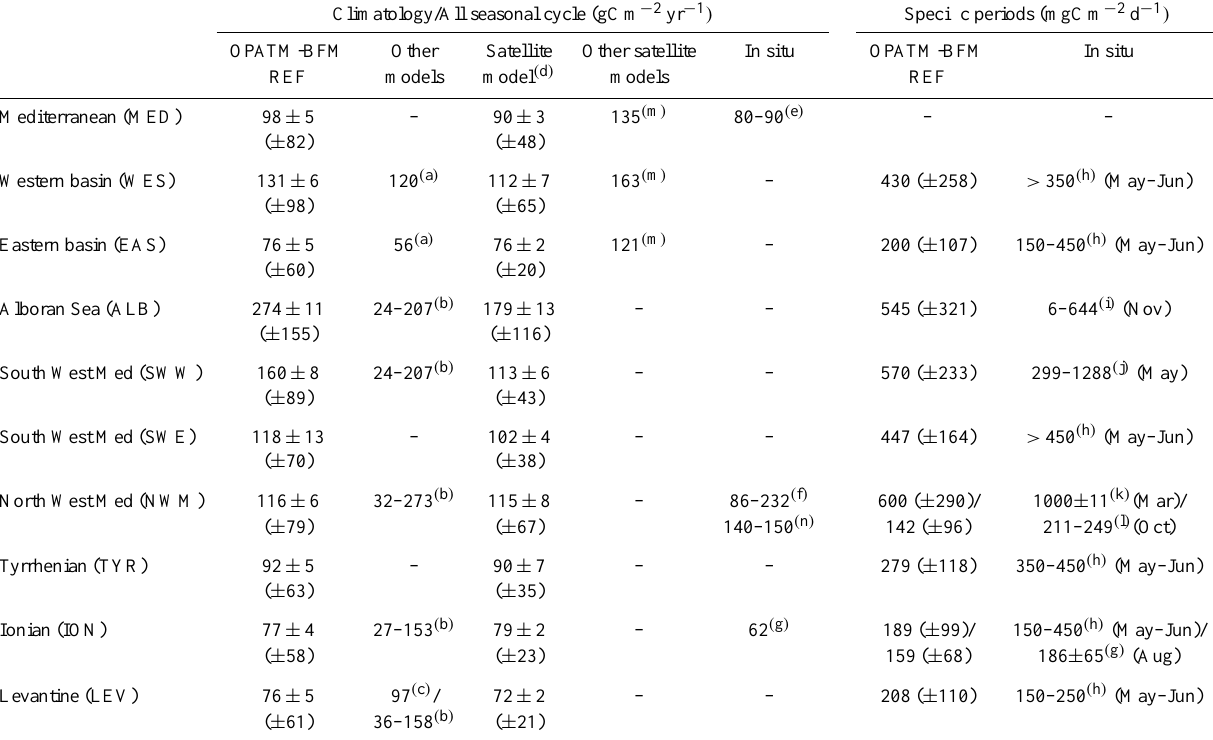
Table 1. Regional averages of net primary production presented as annual value and for shorter specific period selected on the basis of data availability. Data indicate typical mean and (for climatology only) related inter-annual variability, computed as mean and standard deviations of the six annual mean values, respectively. The average of the six standard deviations is reported in parentheses as the typical intra-period variability. References: (a) Crispi et al. (2002), (b) Allen et al. (2002), (c) Napolitano et al. (2000), (d) Colella (2006), (e) Sournia (1973), (f) Marty and Chiaverini (2002), (g) Boldrin et al. (2002), (h) Moutin and Raimbault (2002), (i) Mac´ıas et al. (2009), (j) Lohrenz et al. (2003), (k) Moran and Estrada (2001), (l) Granata et al. (2004), (m) Bosc et al. (2004), (n) Conan et al.